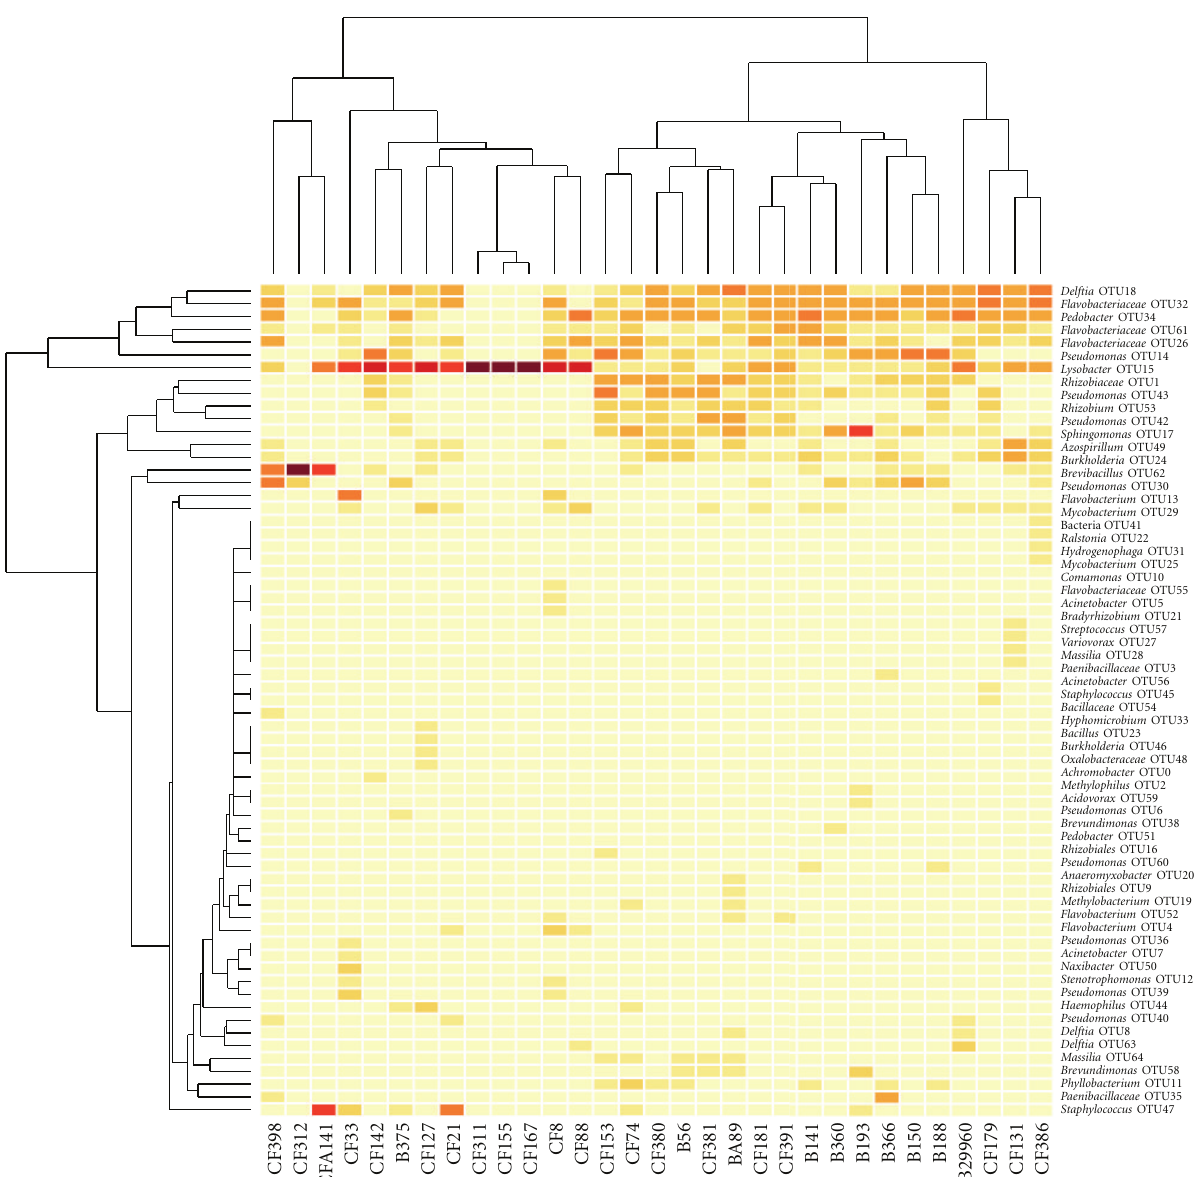
Figure 2: Heatmap showing clustering of bacterial communities and similarities in operational taxonomic unit (OTU) distribution among patients. Sample numbers are listed horizontally along the bottom; “B” indicates bronchiectasis samples, and “CF” indicates CF samples. OTUs and their taxonomic classifications are listed vertically on the right. Darker colors indicate higher abundance; lighter colors indicate low abundance or absence of a particular